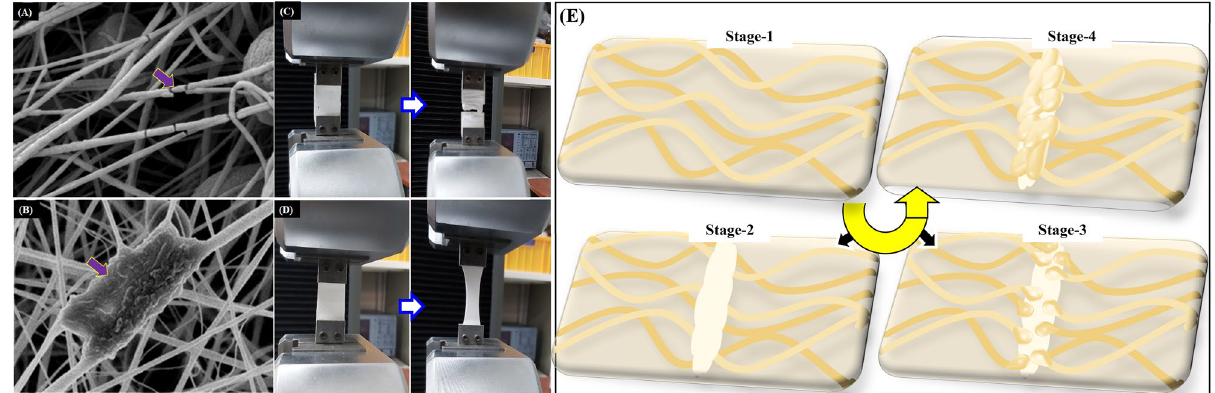
Figure 9. ( A , B ) Micro images of core–shell nano fibers, ( C , D ) digital images of 10TPn and VM–10TPn following repeated stretching by tensile loading and ( E ) Schematic representation of healing